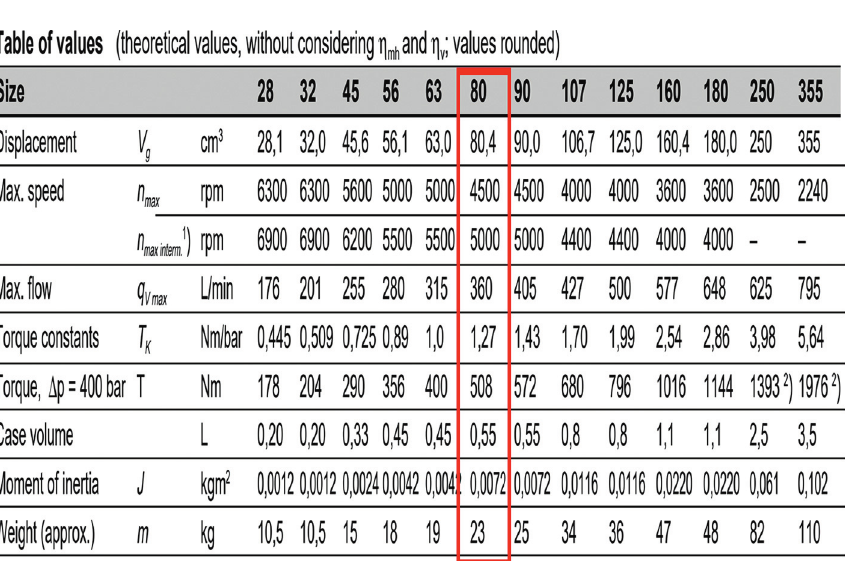
Figure 6: Performance parameters of a hydraulic motor